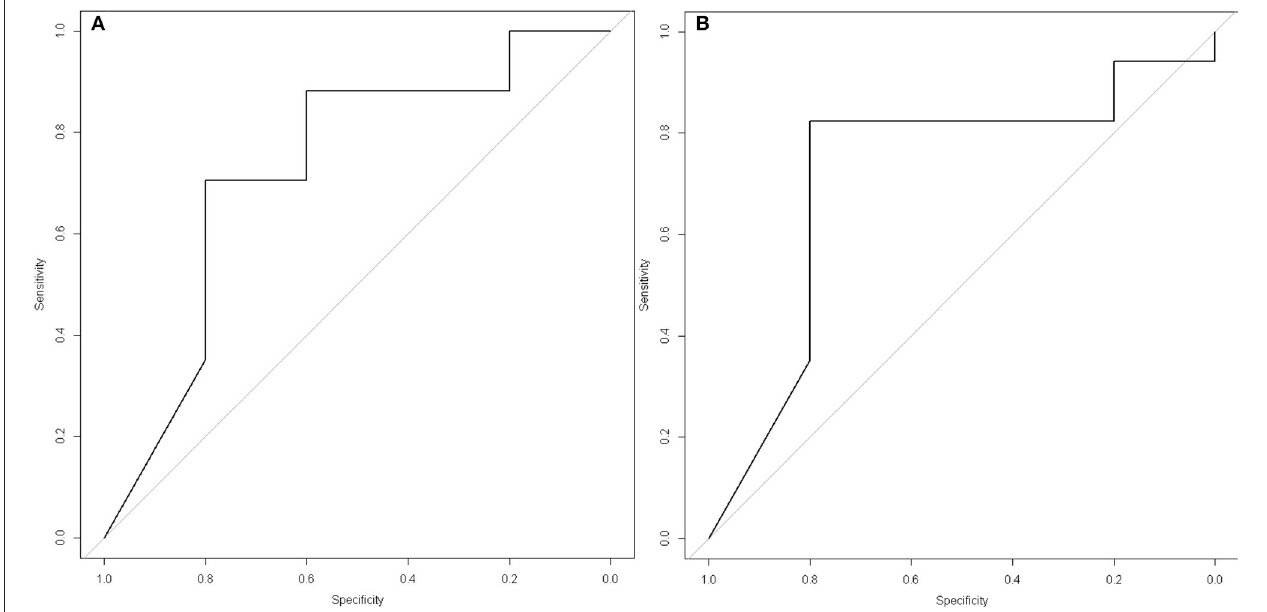
FIGURE 4 | ROC curves with best PET/CT criteria for the diagnosis of healing or residual disease at the end of treatment. (A) Σ SUV on PET2 (at the end of prescribed treatment): AUC = 0.73 [0.42–1.00]), Youden index: 5.6, Sensitivity = 64.7 [42.0–87.4], Specificity = 80.0 [44.9–100.0], Positive Predictive Value of Σ SUV < 5.6 for the diagnosis of healing = 91.7 [76.0–100.0], Negative Predictive Value of Σ SUV ≥ 5.6 for the diagnosis of healing = 40.0 [9.6–70.4]. (B) MSUV on PET2: AUC = 0.72 [0.42–1.00]), Youden index: 3.5, Sensitivity = 76.5 [56.3–96.6], Specificity = 80.0 [44.9–100.0], Positive Predictive Value of MSUV < 3.5 for the diagnosis of healing = 92.9 [79.4–100.0], Negative Predictive Value of MSUV ≥ 3.5 for the diagnosis of healing = 50.0